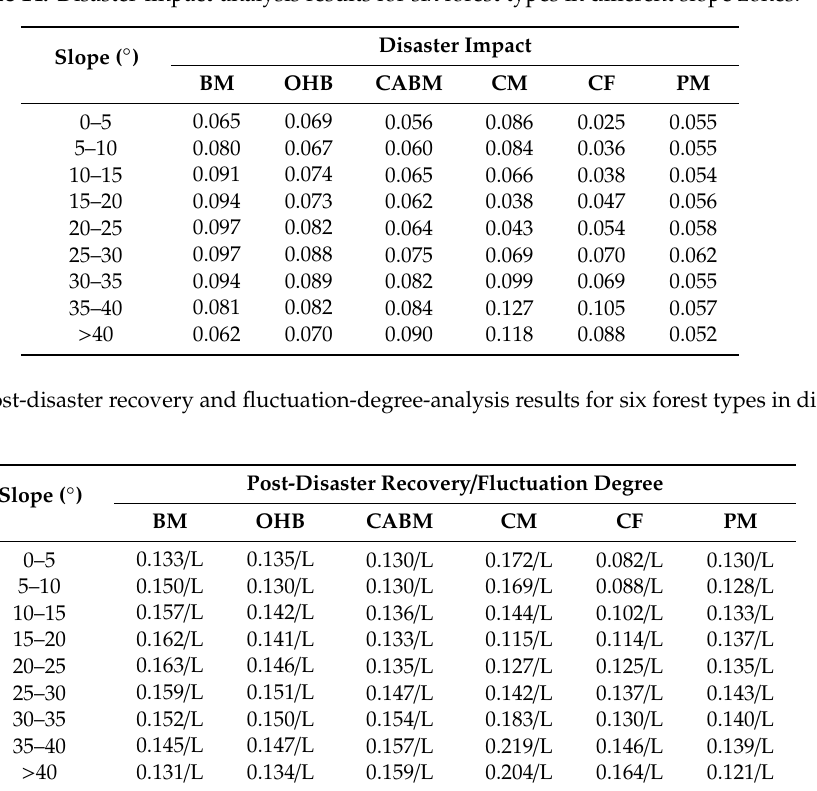
Table 14. Disaster-impact-analysis results for six forest types in di ff erent slope zones.